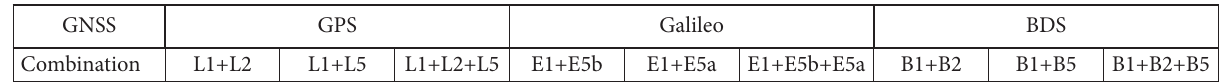
Table 3. Combinations of frequencies for GPS and